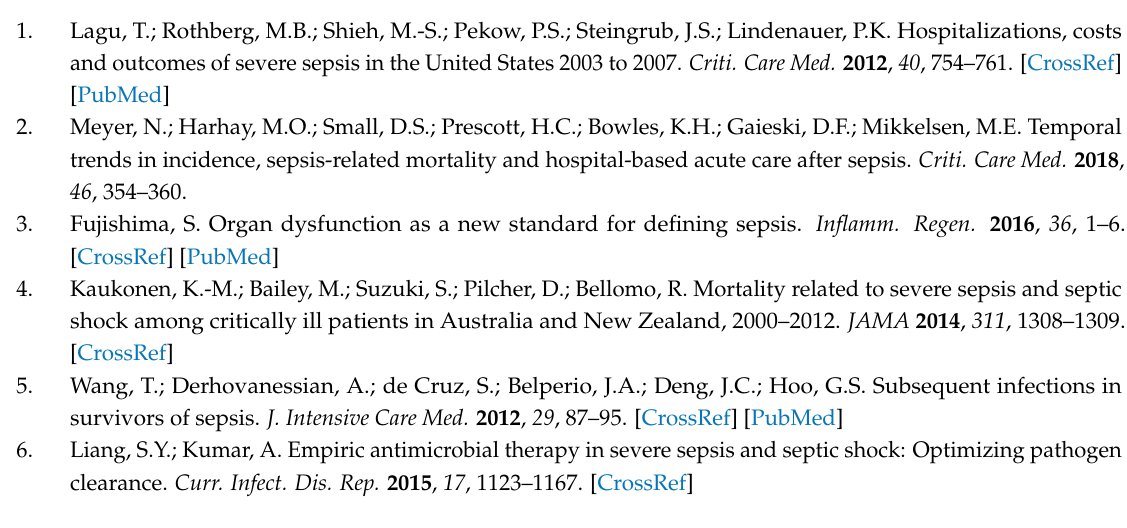
Table S1: Characteristics of Patients with Recurrent Sepsis, Table S2: Characteristics of Causal